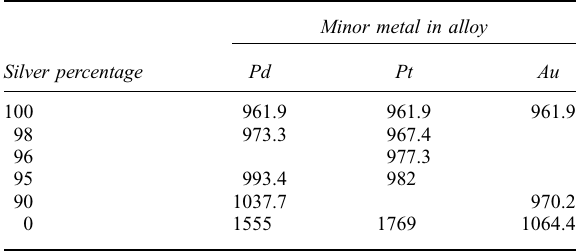
TABLE I Melting Temperature of Different Metal Alloys Powders.